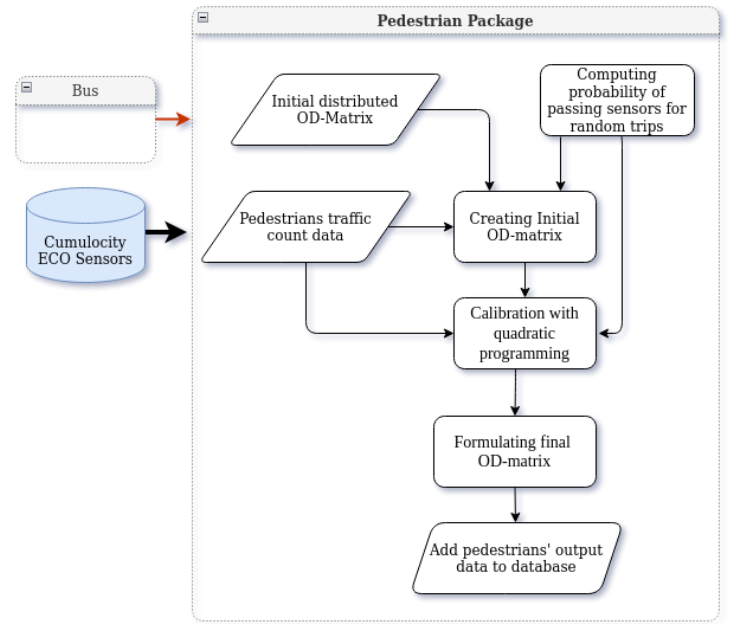
Figure 9. Pedestrian package